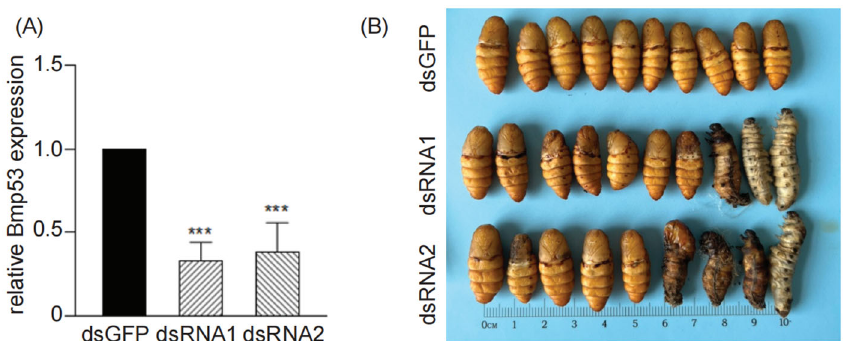
Figure 3. dsRNA-mediated knockdown of Bmp53 . ( A ) Knockdown of endogenous Bmp53 transcript levels in BmN cells following transfection with dsRNAs targeting different regions of Bmp53 (dsRNA-1 and dsRNA-2) or GFP( *** p < 0.001). ( B ) Effects of Bmp53 knockdown on B. mori pupation. Injections were performed using 6-d-old fifth instar larvae, and pupae were imaged 5 d post injec- tion.